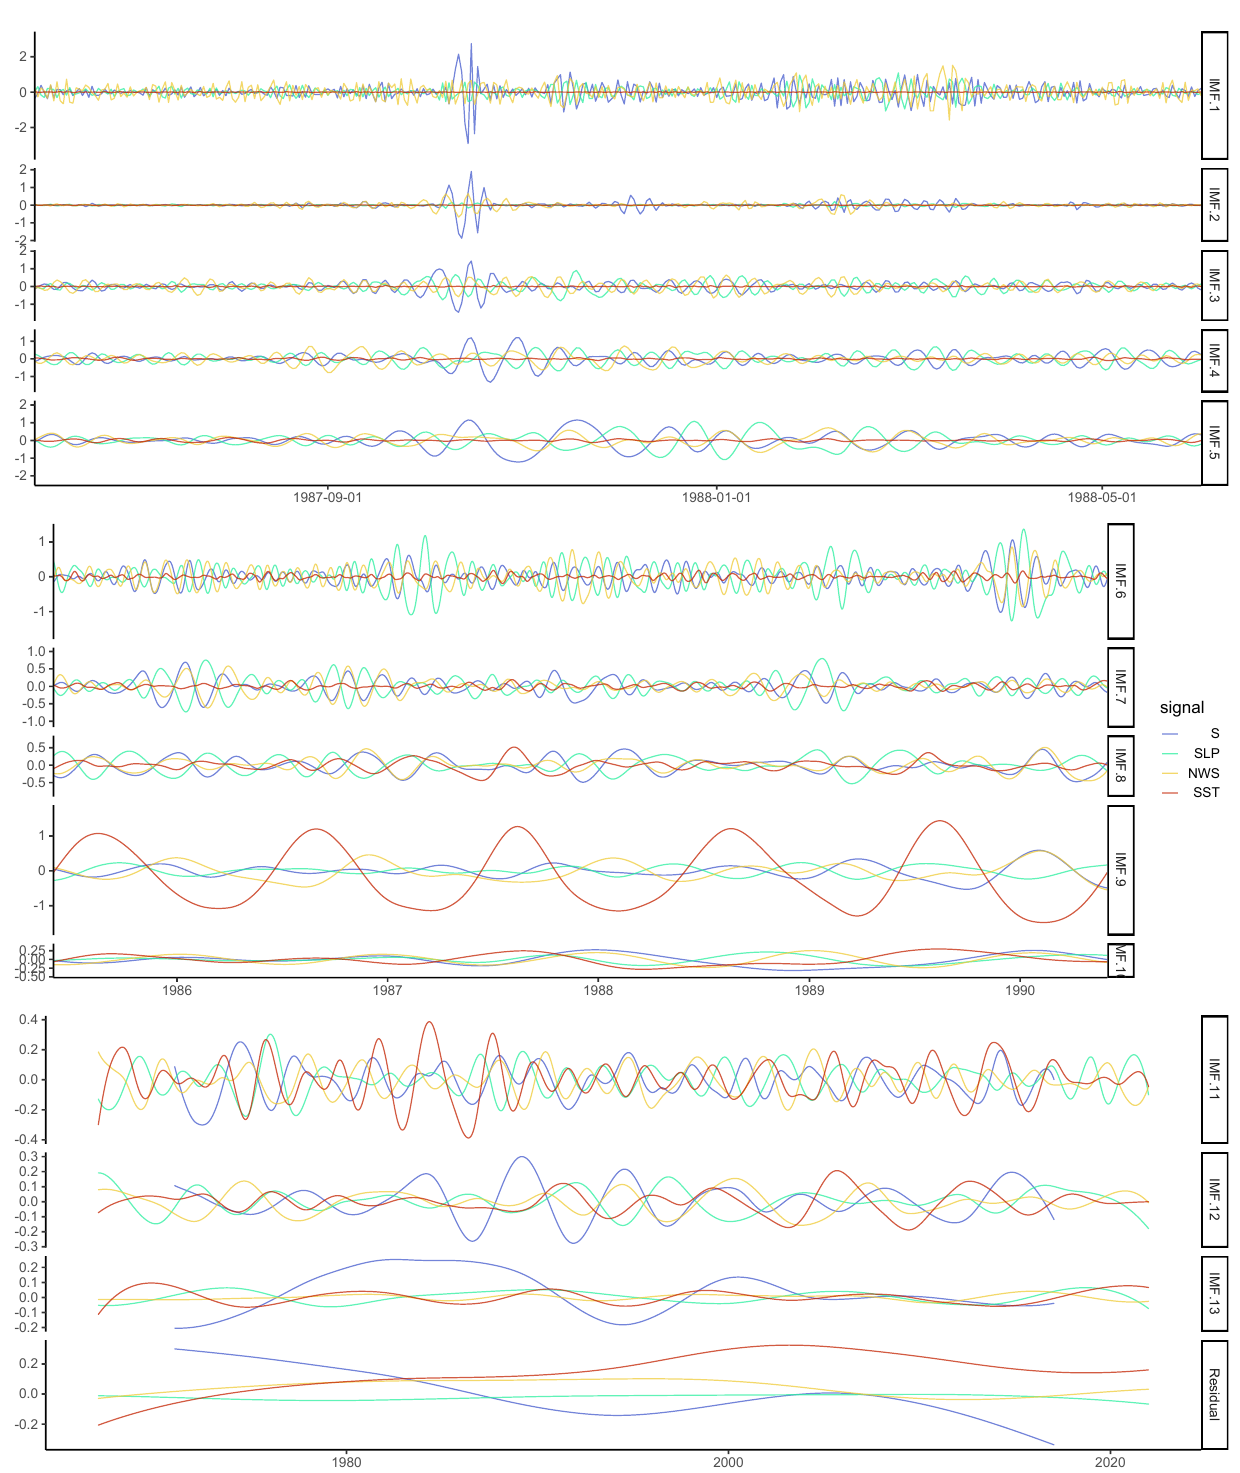
time Figure 5. Decomposition by CEEMDAN of the S variable and the SLP, NWS and SST covariates taken at the coordinates of maximal absolute correlation with S -d in Figures 3 and 4. For readability, IMFs 1 to 5 are displayed for one year only and IMFs 6 to 10 are displayed for 5 years. Signals are scaled to have zero mean and unit standard deviation before decomposition. The vertical scale is constant between IMFs inside each duration group only. The maximal S observation of the analyzed period was on 16 October 1987, which explains the abnormal